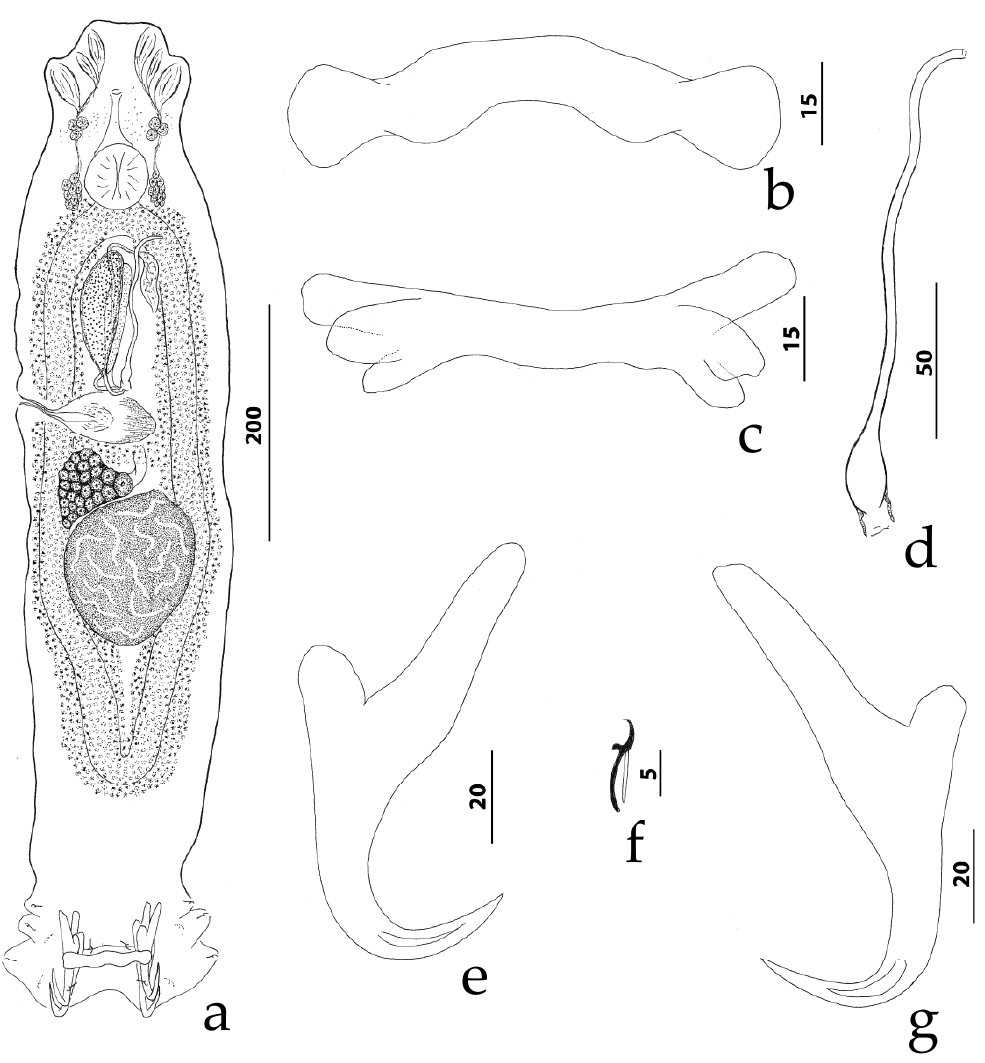
Figure 6. Platycephalotrema thysanophrydis (Yamaguti, 1937) n. comb. ( a ). Whole mount (composite, ventral view); ( b ). ventral bar; ( c ). dorsal bar (ventral view); ( d ). male copulatory organ (ventral view); ( e ). dorsal anchor; ( f ). hook; ( g ). ventral anchor. 3.8. Platycephalotrema platycephali (Yin & Sproston, 1948) n. comb. Syns Haliotrema platycephali Yin & Sproston, 1948; Ancyrocephalus platycephali (Yin &